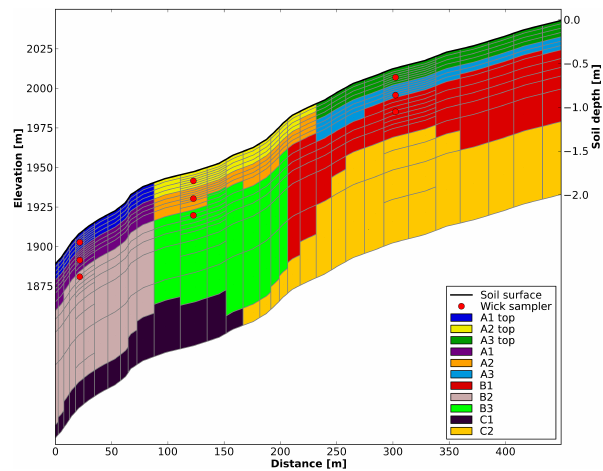
Figure 2. Elevation profile (top black line, left ordinate), succes- sion of soil layer types (color plate) and soil depths assigned to the modeling grid (right